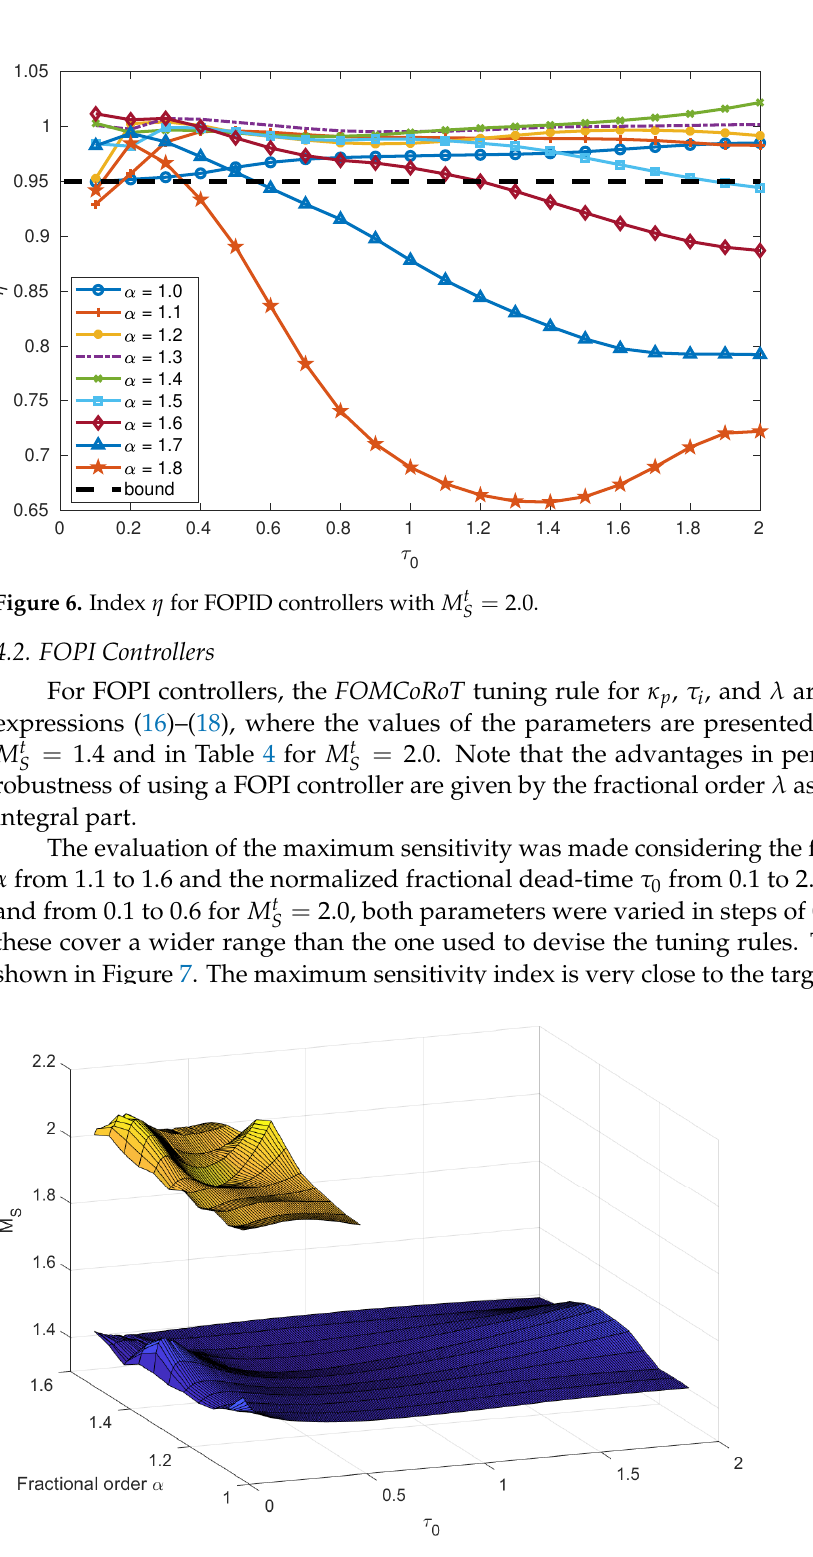
Figure 7. Evaluation of M S for